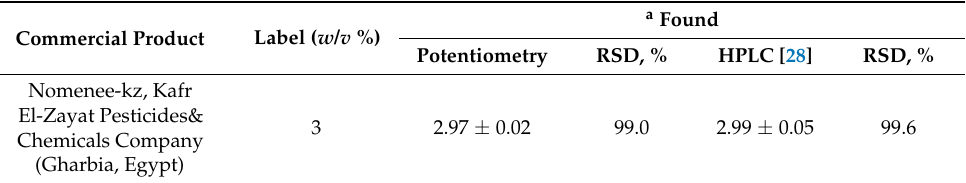
Table 2. Potentiomeric determination of bispyribac in commercial herbicide formulation using MIP/PANI membrane based sensor.